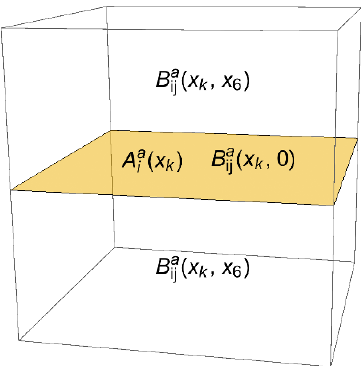
Figure 1 . Sketch of B - and A -(cid:12)elds in 6d space. The B -(cid:12)eld has 5-indices (in B i 6 = 0 gauge) but depends on all 6 coordinates. The A -(cid:12)eld \lives" only in a codimension-1 subspace with x 6 = 0 (colored region) where the interaction takes